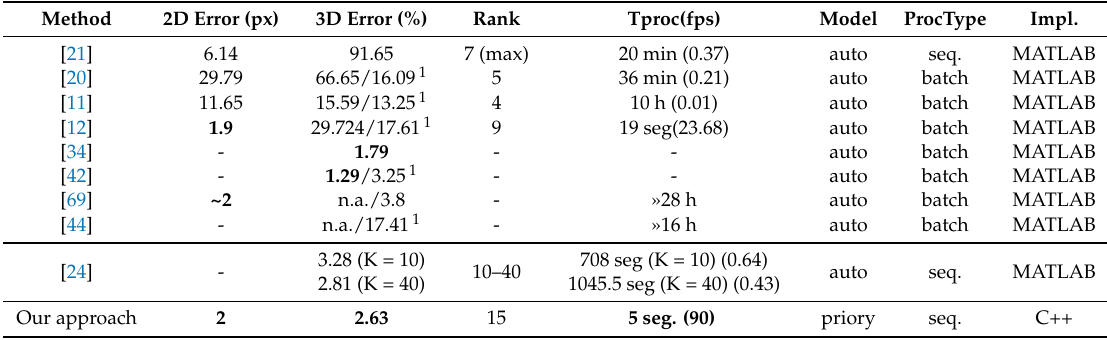
Table 2. Flag sequence results summary. Some results comparing several state-of-the-art algorithms and the presented one are